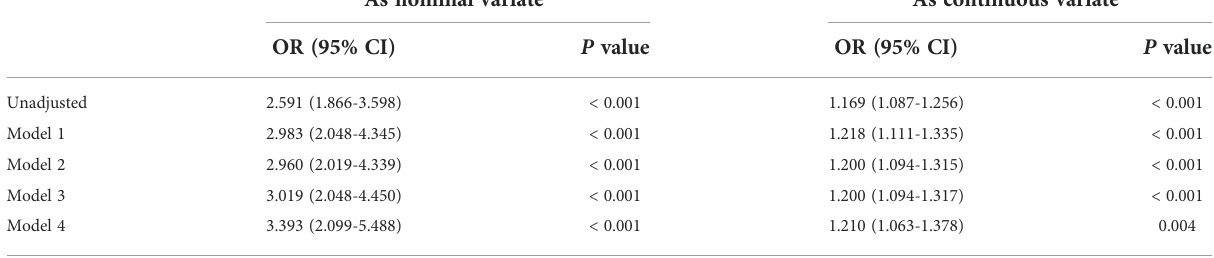
TABLE 2 Association of eGDR with ISR in multivariate logistic regression